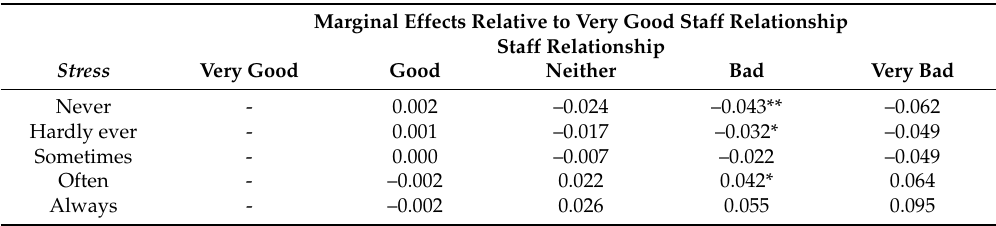
Table A7. Estimated marginal effect of relationship between staff on work-related stress—females.